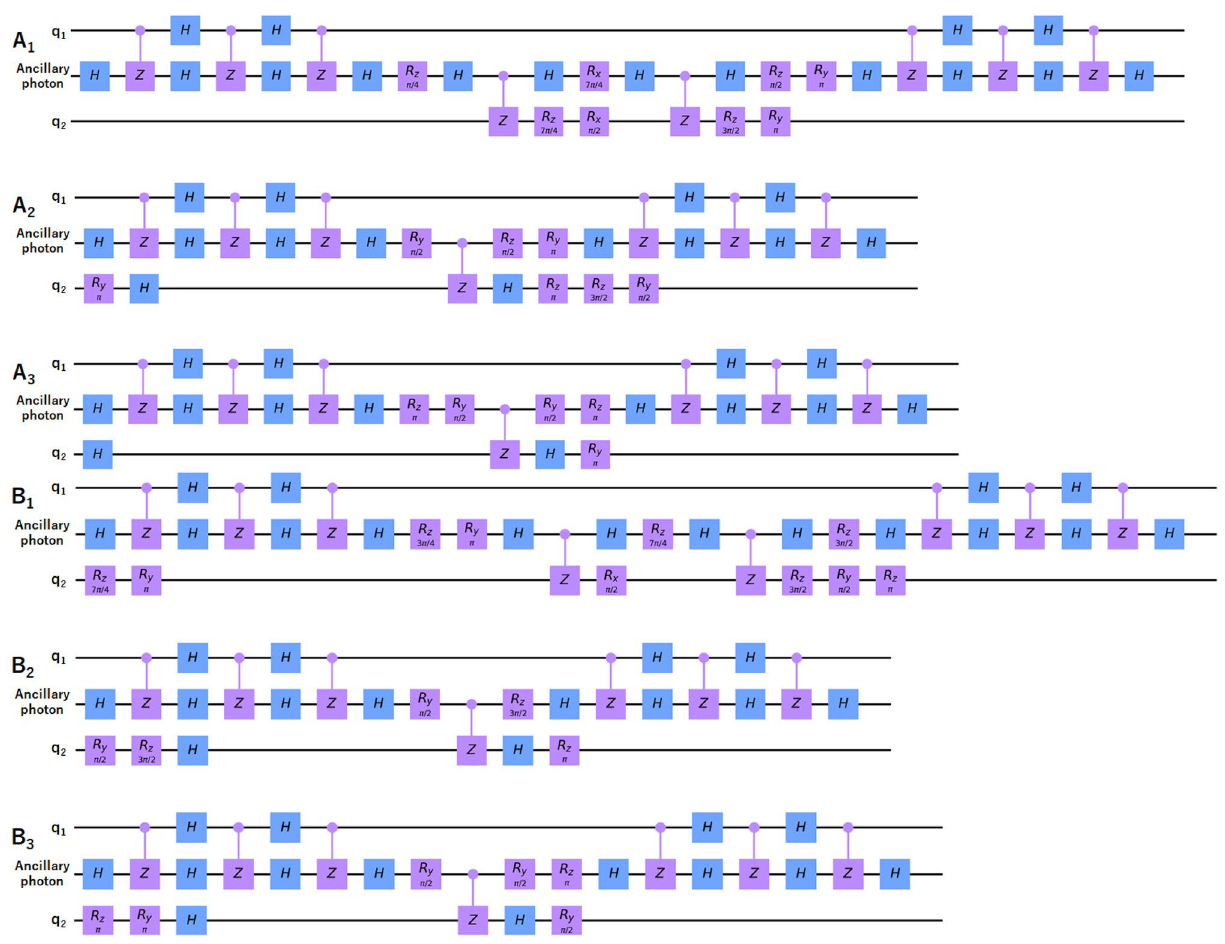
Figure 2. Circuit diagrams for realizing the operations of players. Blue H gate represent a Hadamard gate, purple gates represents Controlled-Z (CZ) gate or R x , R y , and R z gates which are rotation around x, y, and z axis, respectively. Referee gives the row number a to Alice and column number b to Bob. Alice applies A a and Bob applies B b , each to his/her two spin qubits ( q 1 and q 2 ) in distant optical cavities through an ancillary photon.